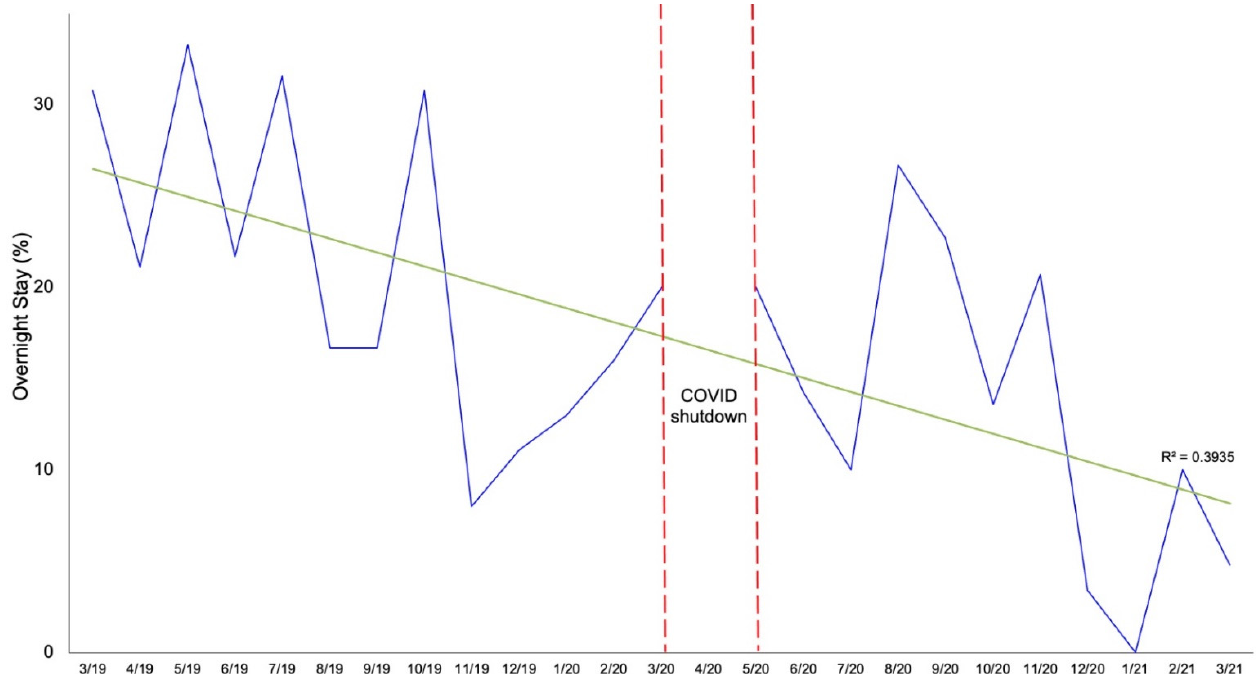
Figure 2. Rate of shoulder arthroplasties requiring overnight hospital stays over